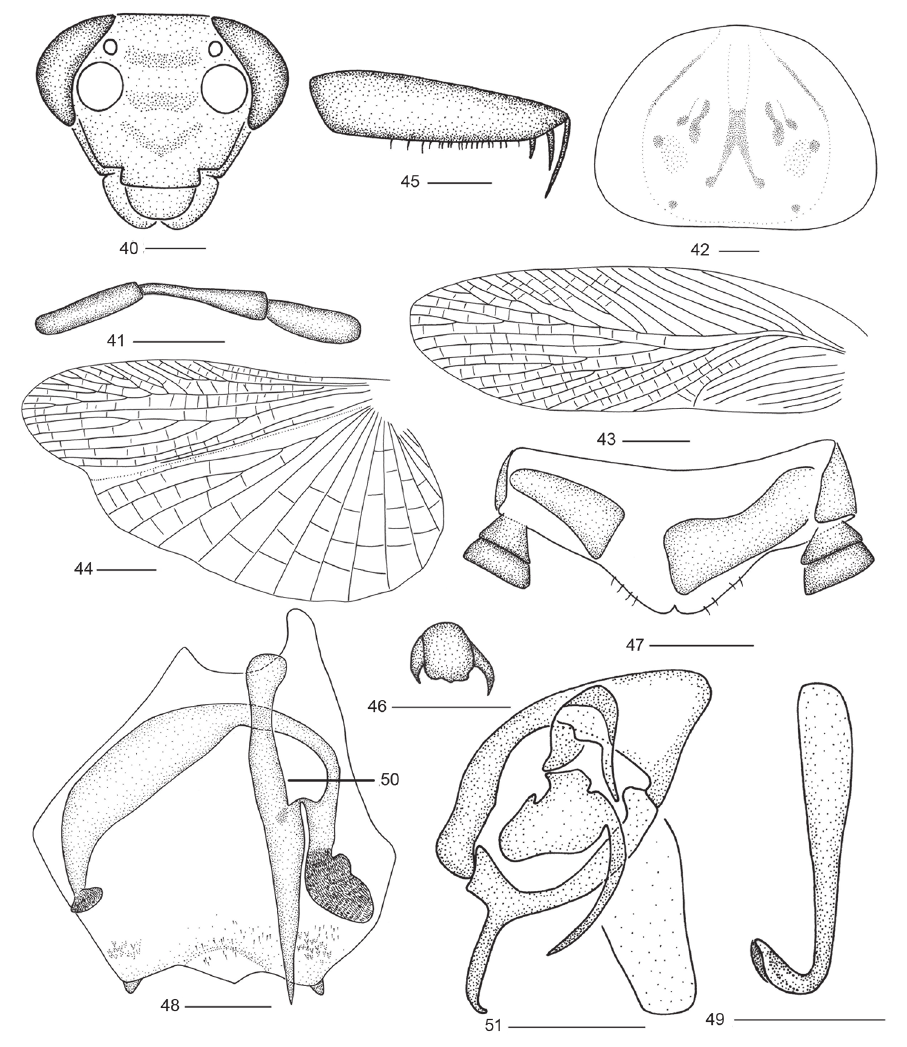
Figures 40–51. Balta tangi sp. n. 40 head 41 maxillary palps 42 pronotum 43 tegmen 44 hind wing 45 front femur; 46 tarsal claws and arolium 47 supra-anal plate and paraprocts, ventral view 48 subgeni- tal plate, dorsal view 49 right phallomere 50 median phallomere 51 left phallomere; Scale bars: 0.5 mm ( 40–42, 45–51 ), 2.0 mm ( 43, 44 ). tered and symmetrical blackish brown spots, lateral borders of pronotum hyaline (Fig. 42). Lateral border of abdomen sterna with round blackish brown spots (Fig. 6). Third and fourth maxillary palpomeres nearly the same length, distinctly longer than the fifth (Fig. 41). Hind wing with triangle apical, near apex of R with posterior branches, CuA with three complete branches (Fig. 44). Front femur type C (Fig. 45), tarsal claws 3 strongly asymmetrical and unspecialized (Fig. 46). Abdominal tergites